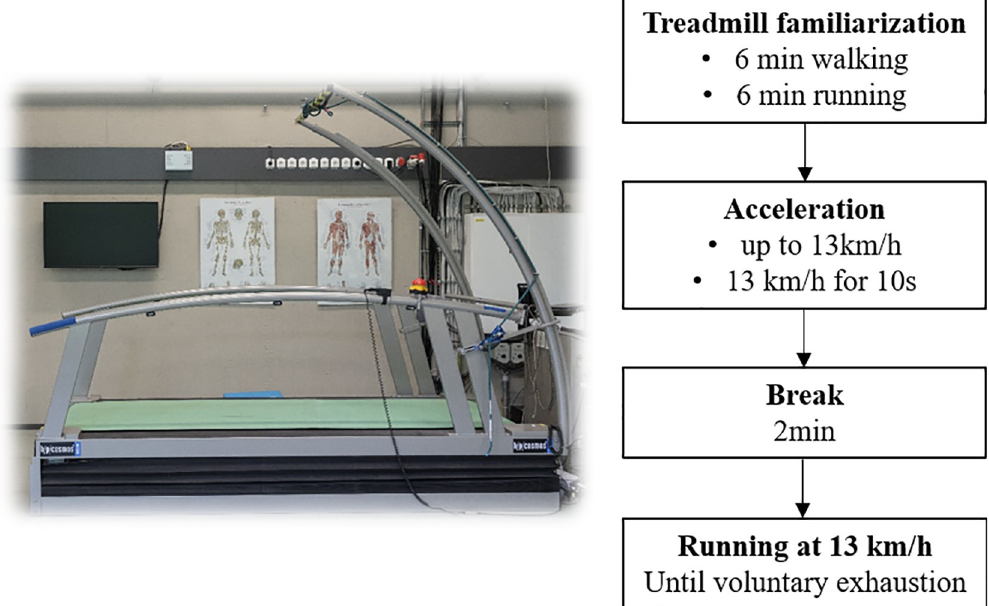
Fig 1. Illustration of the experimental design and picture of the treadmill used in the